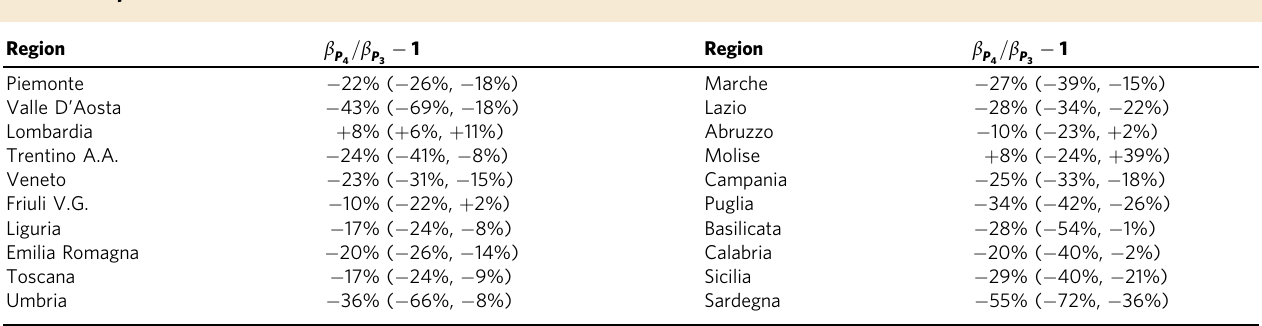
Changes of the estimated transmission rate after the relaxation of the lockdown for the 20 Italian regions. Median values and 95% con fi dence